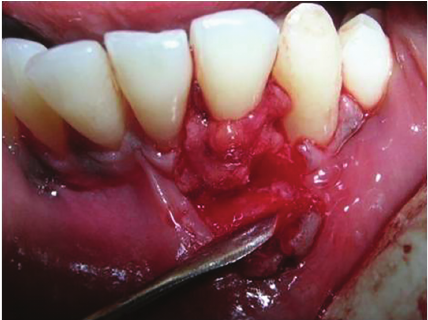
Figure 8: Papillary grafts from adjacent papillae first sutured midbuccally in relation to recipient site.